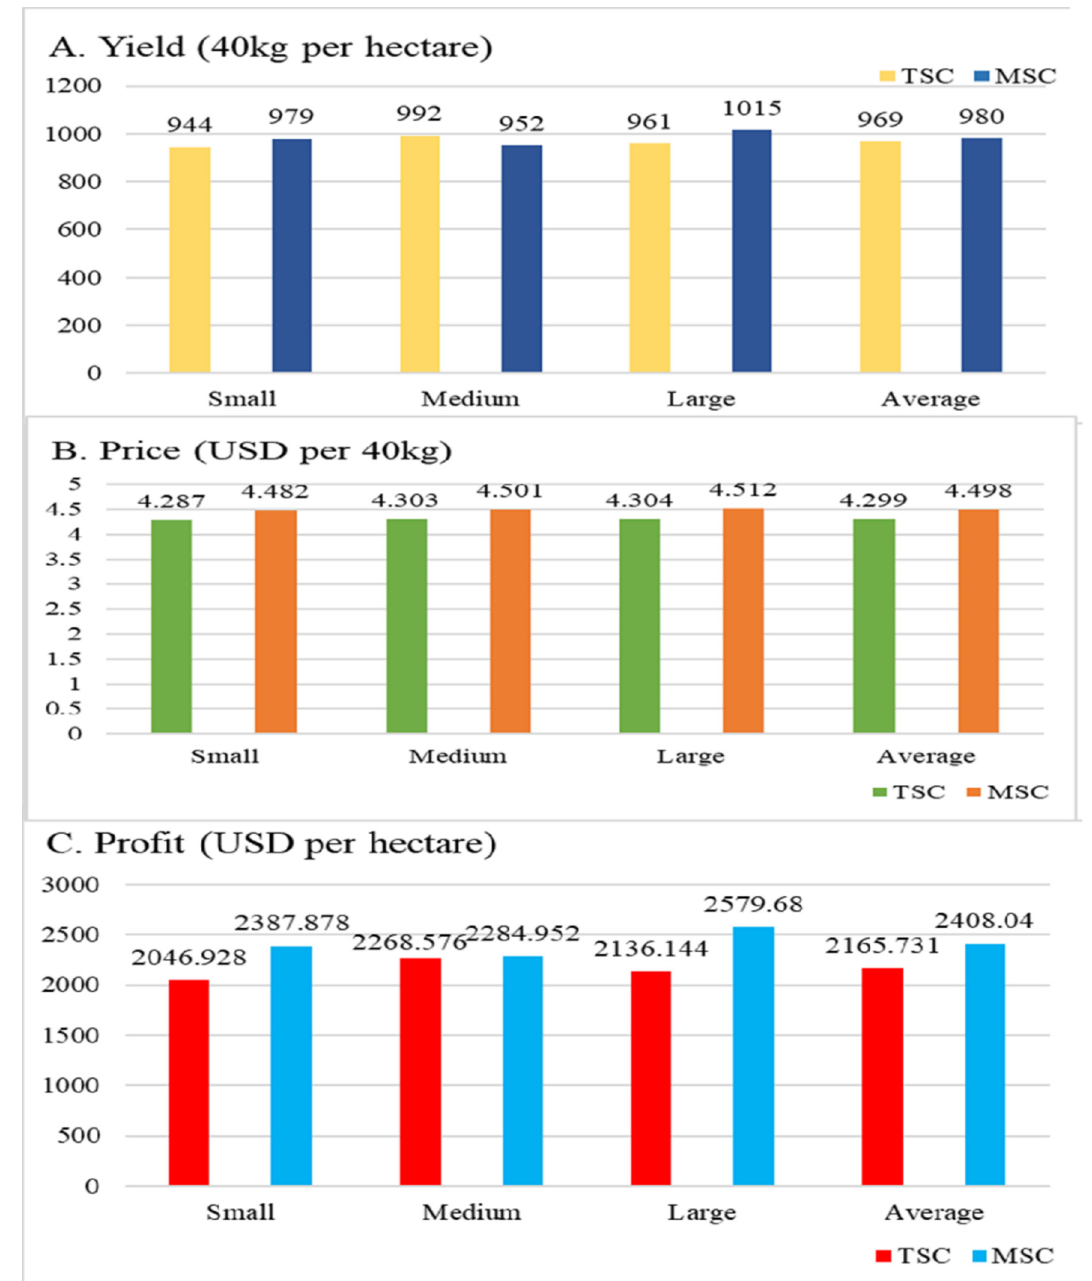
Figure 3. Partial productivity indicators at the upstream level of the mandarin supply chain.